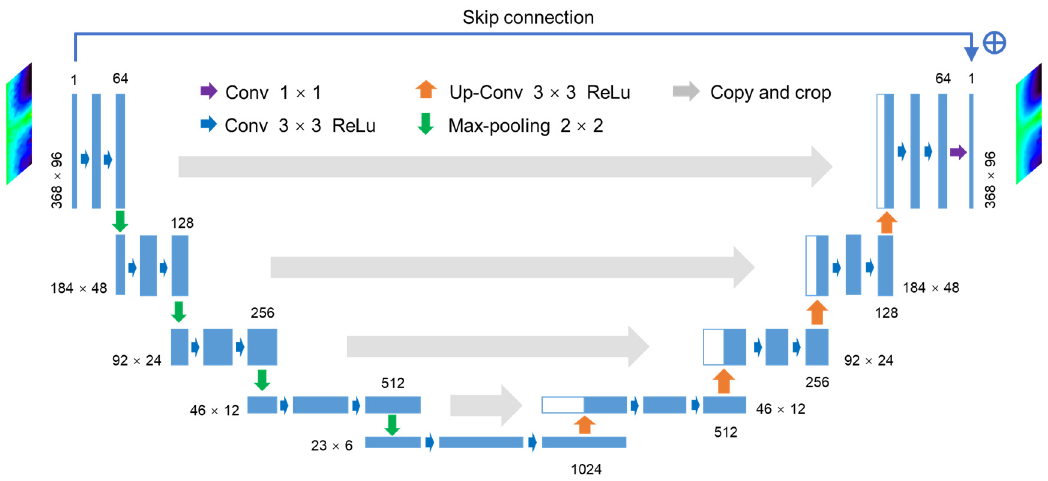
Figure 7. Architecture of the Res-U-net network.